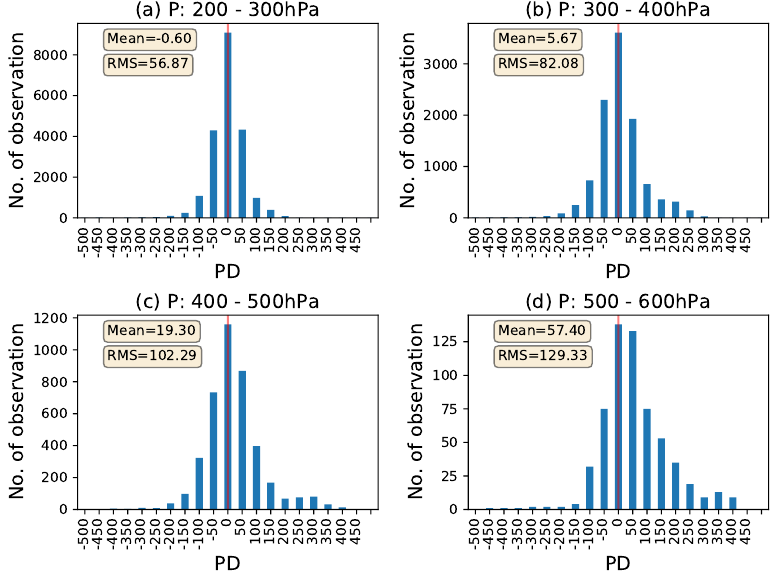
Figure 6. Same as Figure 5 except for GK2A IR winds derived using IR/WV intercept. Due to the characteristics of the IR/WV intercept, data exist only at altitude above the 600 hPa